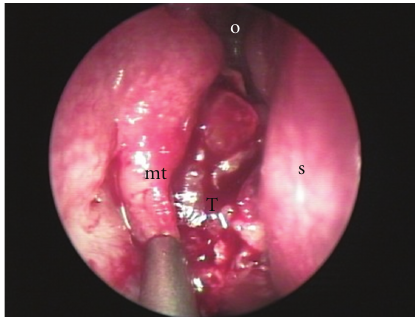
Figure 3: Initial lesion, endoscopic view: the tumor (T) is centered on the olfactory cleft (o), pushing the septum (s) medially and the middle turbinate (mt)